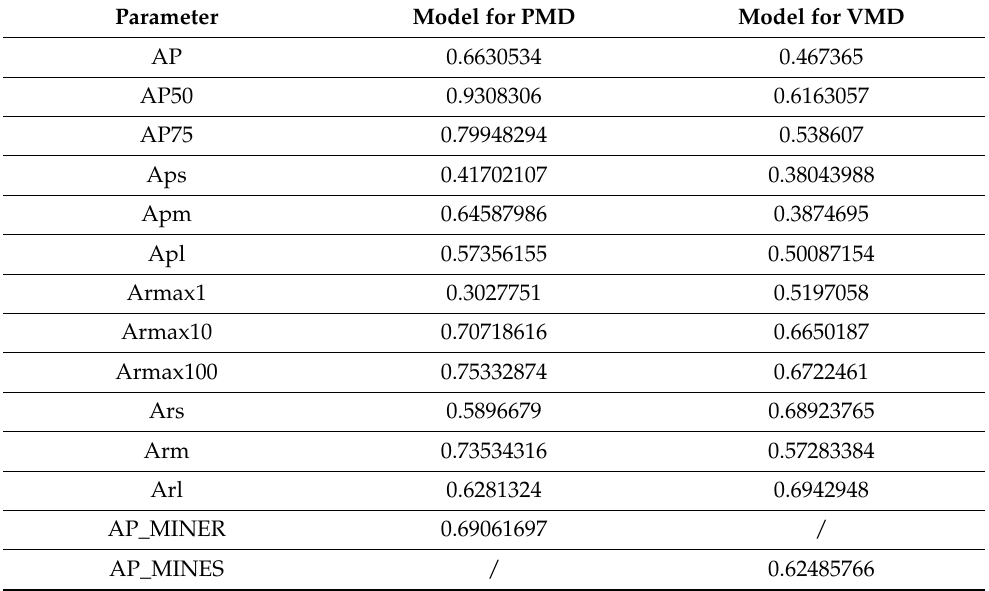
Table 1. Validation parameters of the models for the PMD and VMD.